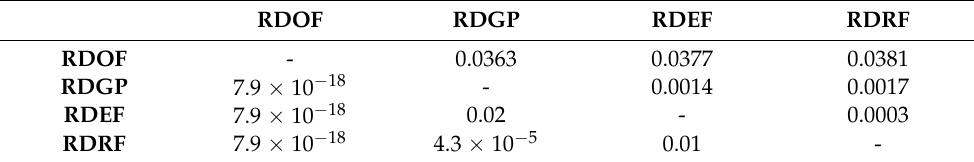
Table 5. To the right of the diagonal stand the estimated differences of RMSE between models for raw data. To the left of the diagonal stand the adjusted p -values for the H 0 (null hypothesis): difference = 0.